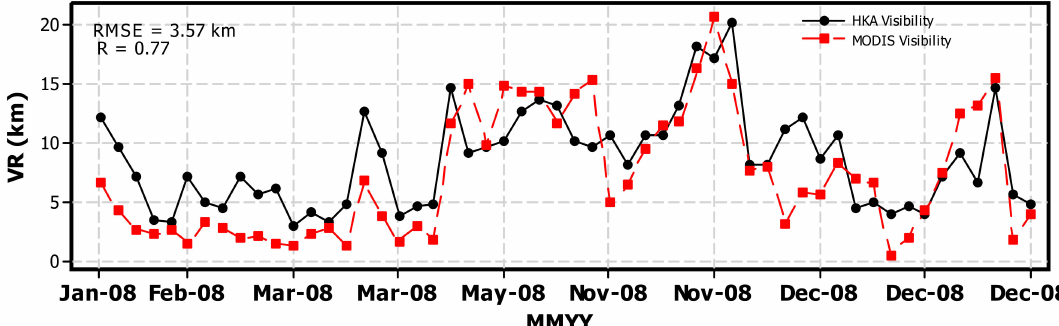
Figure 14. Time series of real-time and simulated VR at HKIA from Model 2 for the validation data set (MODIS AOD and climatic data) of 2008 over HKIA.